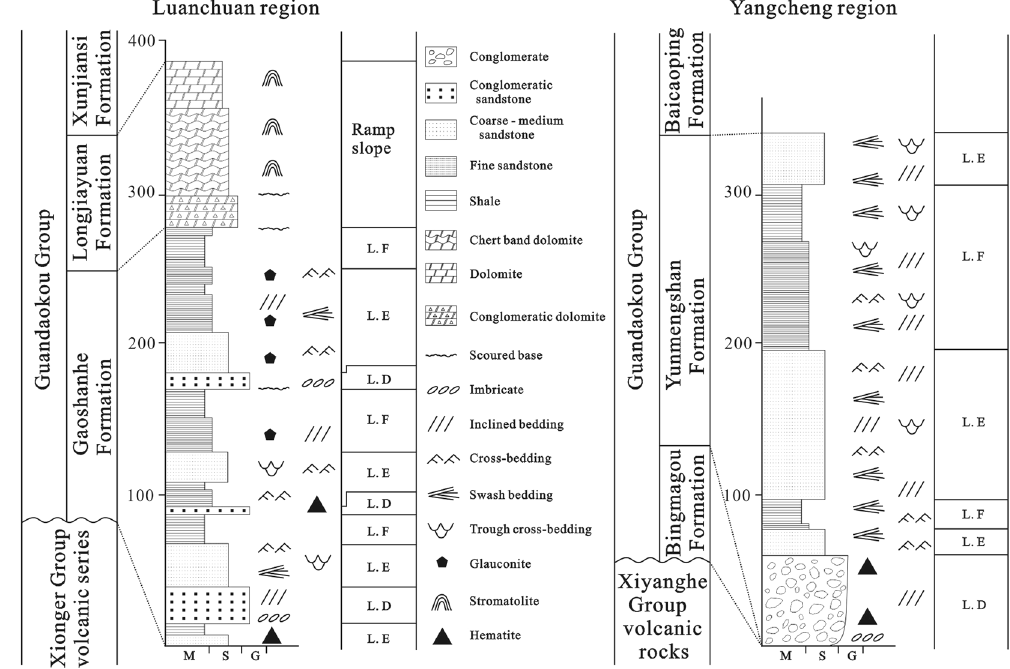
Figure 6. Composite columnar stratigraphic section of the Luanchuan and Yangcheng